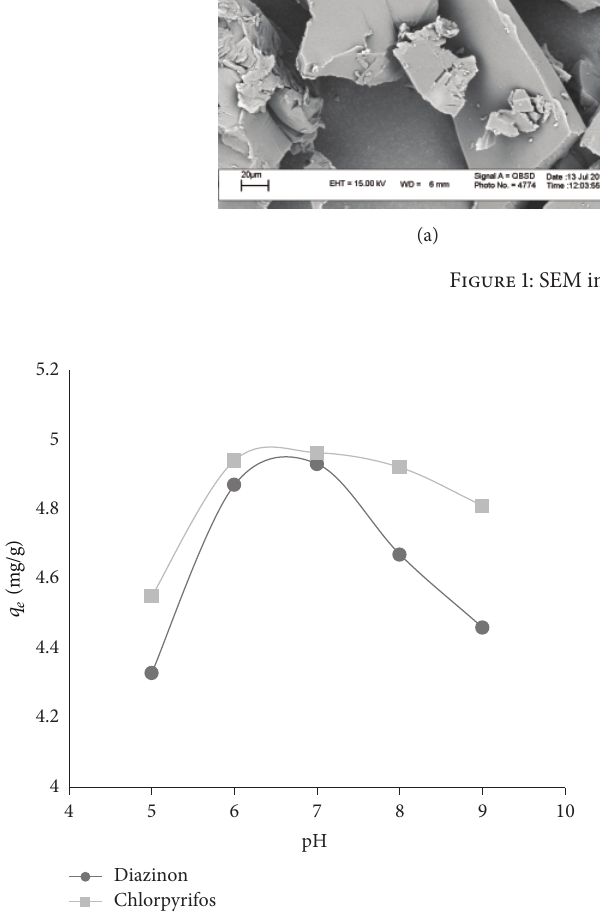
Figure 3: Effect of contact time on adsorption of diazinon and chlorpyrifos by